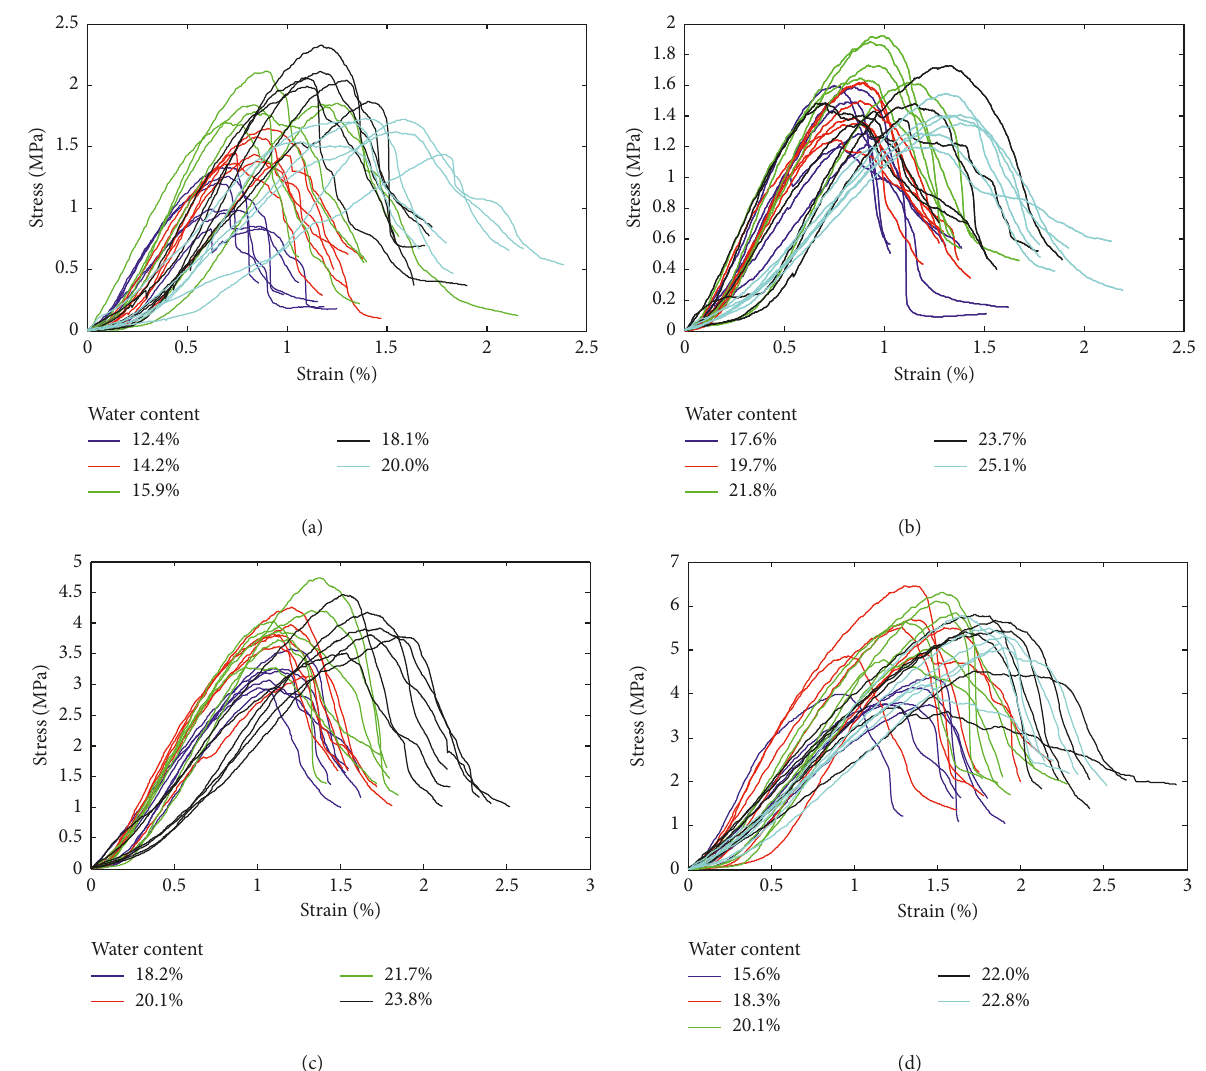
Figure 6: Compressive stress-strain curves of specimens: (a) without CMC and with (b) 0.5% CMC; (c) 1.0% CMC; (d) 1.5% CMC.